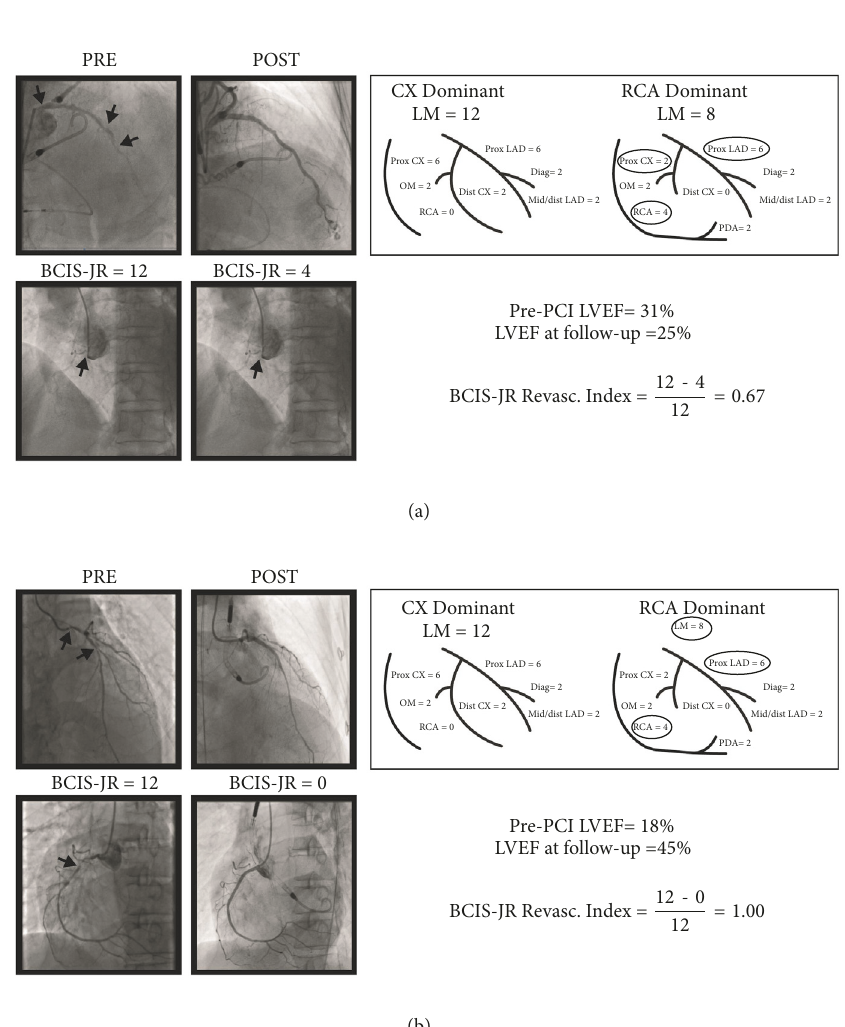
Figure 1: British-Cardiovascular-Intervention-Society jeopardy-score (BCIS-JS) calculation examples in a patient with complete (a) and in a patient with incomplete (b) myocardial revascularization . Patient in (a) showed a significant improvement of left ventricular function, while patient in (b) died after 6 months of follow-up. Arrows indicate significant coronary stenosis. PCI=percutaneous coronary intervention and LVEF=left ventricular ejection